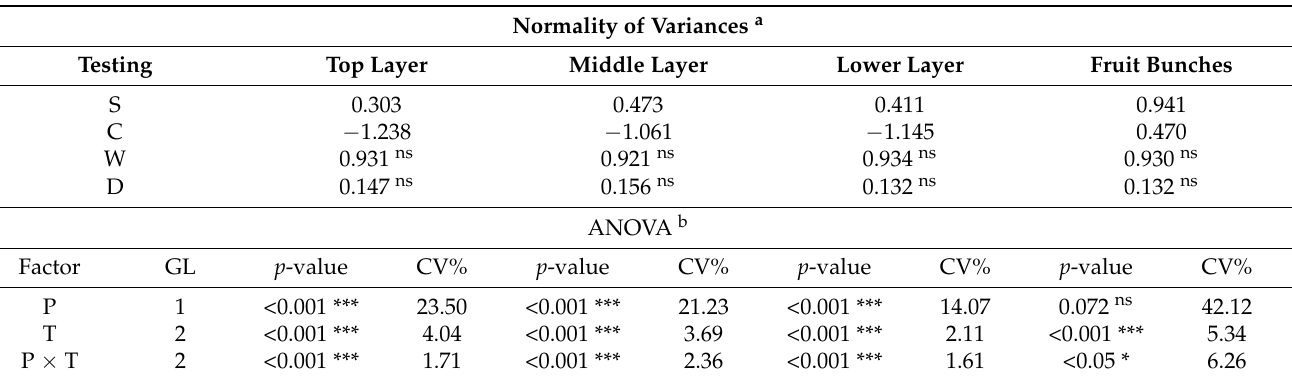
Table 3. Normality and analysis of variance (ANOVA) for droplet coverage at different plant layers and fruit bunches of papaya.